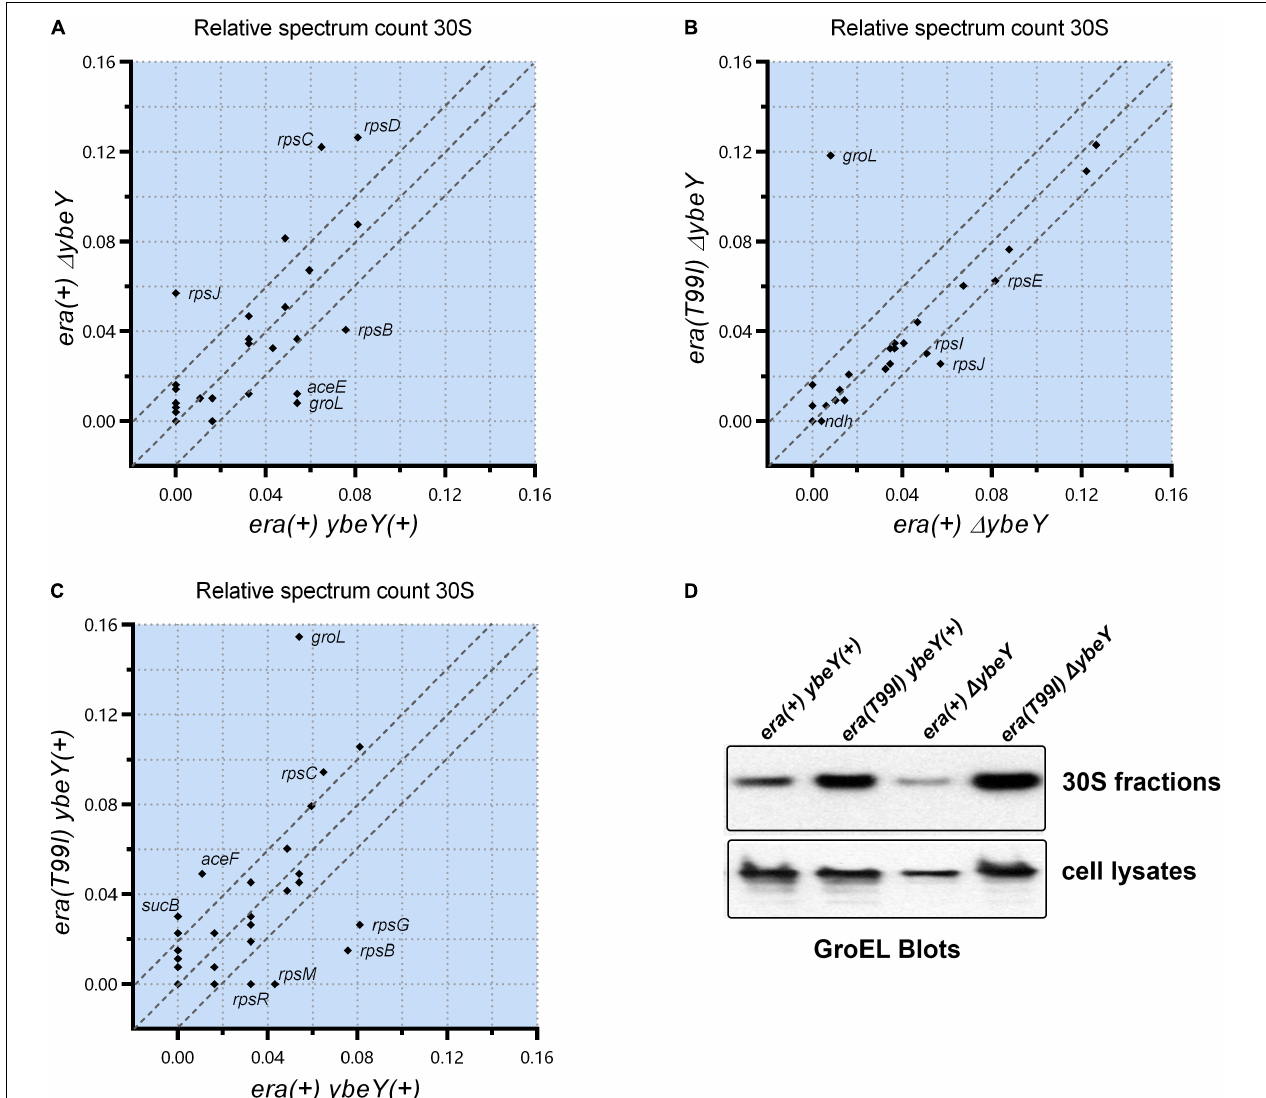
FIGURE 6 | Relative spectrum count of the peptides identified by mass spectrometry is shown as comparison between strains era( +) ybeY( +) and era( +) (cid:49) ybeY in (A) , era( +) (cid:49) ybeY and era(T99I) (cid:49) ybeY in (B) , and era( +) ybeY( +) and era(T99I) ybeY( +) in (C) . The data points are labeled by the gene name that expresses the identified peptide. The region between the parallel dotted lines represents the location of the peptides that differ by less than 20%. (D) Western blot analysis of GroEL protein levels in the 30S fractions (upper panel) and in the cell lysates (lower panel) from the indicated